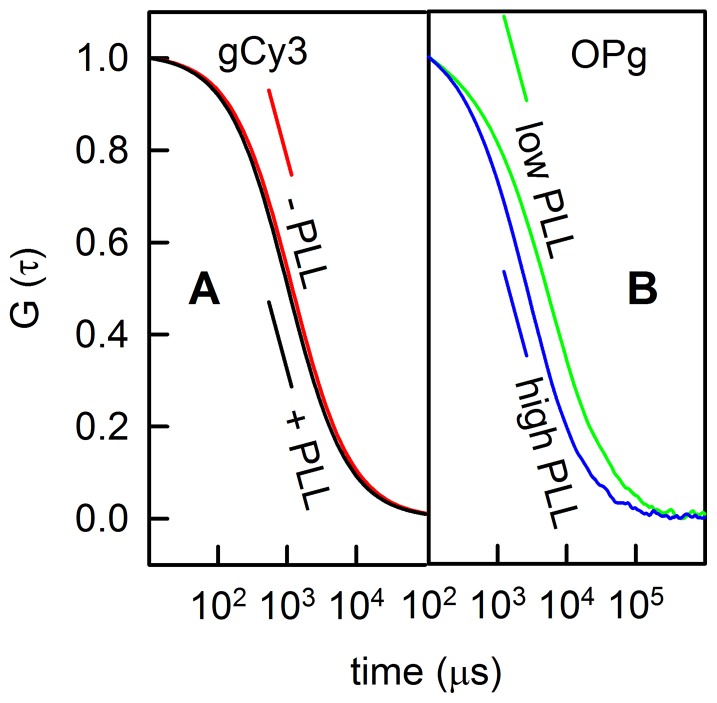
PLL (115 residues) binding to free-standing planar membranes.(A) Representative autocorrelation curves obtained for gCy3-doped planar lipid bilayers prior to (red line) and subsequent to (black line) the addition of PLL to both sides of the membrane. (B) FCS autocorrelation functions for labeled PLL (Atto633) added to both sides of OPg-doped planar lipid bilayers at a concentration of ∼ 0.7 µM (green line) and ∼ 500 µM (blue line) per lysine monomer. Only triply charged OPg, not singly charged gCy3 interacted with PLL strong enough so that a decrease in mobility became measureable (green line). The autocorrelation function indicates the absence of clusters (blue line). It is thus similar to autocorrelation functions for PLL concentrations (per lysine residues) in the nM range and >100 µM. The membranes in A were painted from a 50∶50 (V:V) % mixture of lipid (20 mg DPhPC per ml decane) and gCy3 (0.001 mg per ml ethanol). The membranes in B were folded from monolayers containing OPg (0.5 mg OPg and 20 mg DPhPC per ml hexane). The bathing solution was 25 mM KCl, 10 mM HEPES, 0.1 mM EDTA, pH 7.